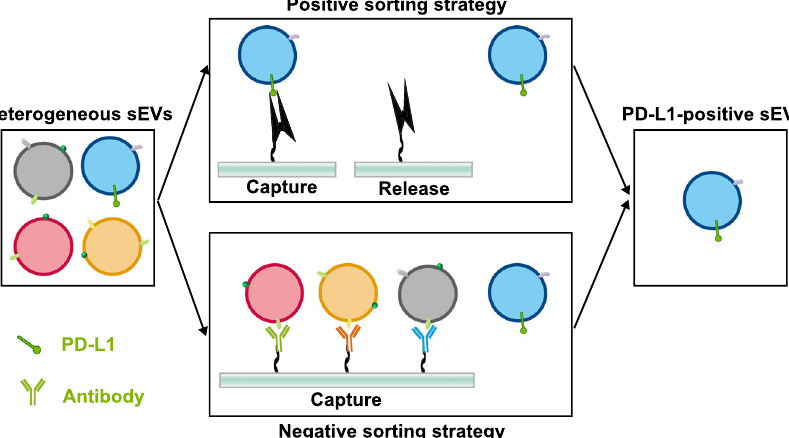
Fig. 5 The nondestructive isolation strategies for selective enrichment of sEV PD-L1. Nondestructive isolation strategies for PD-L1-positive sEVs generally fall into two major categories, the ‘ positive sorting strategy ’ and ‘ negative sorting strategy ’